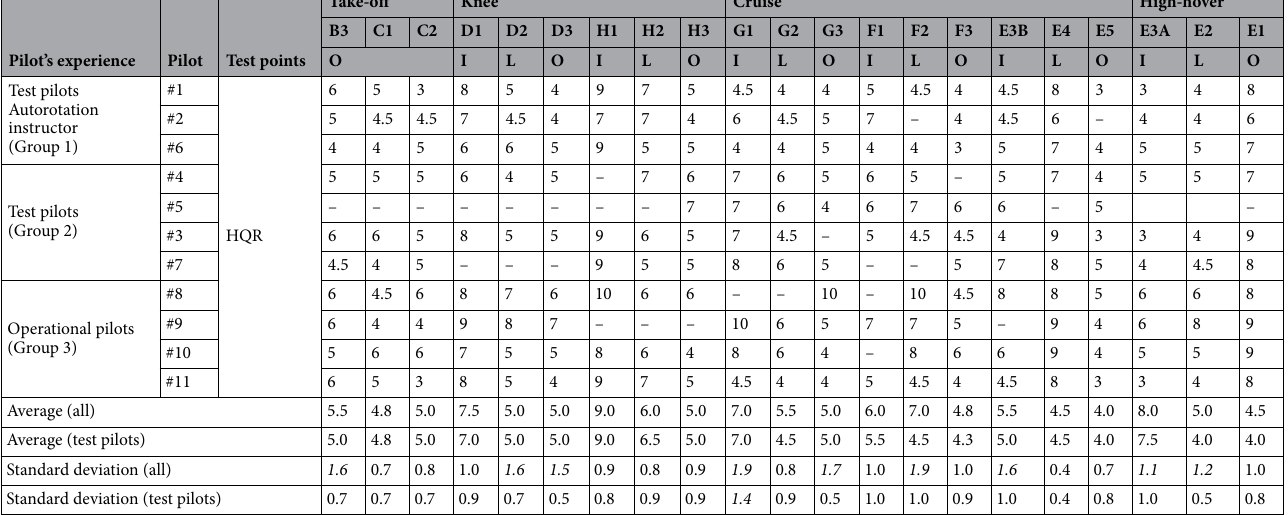
Table 3. Results of the handling qualities assessment. Group 1—highly experienced test pilots; Group 2—test pilots; Group 3—operational pilots. Numbers in italics represents a failure to meet the BIUG requirement 27